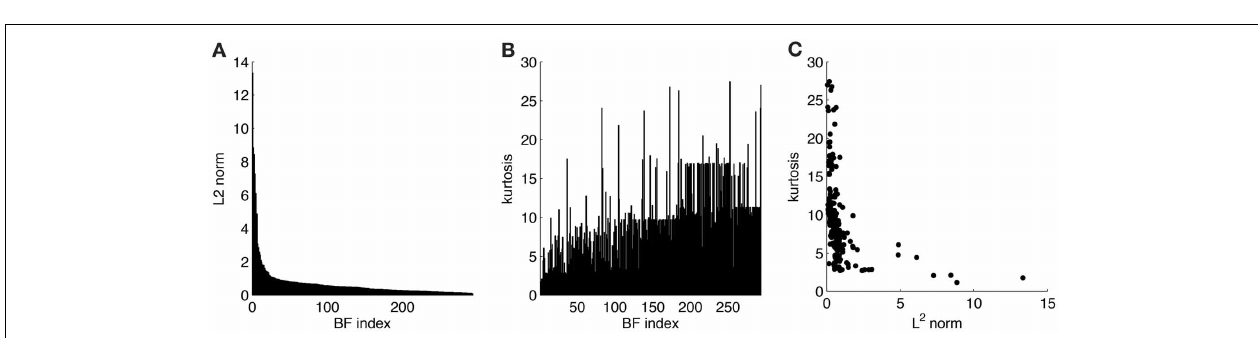
FIGURE 4 | Statistics for learned ICA basis functions. (A) Histogram of L 2 norms for every individual basis function after sorting. (B) Lifetime kurtosis of the source coefficients for each basis function (sorted as in A ). (C) Lifetime kurtosis vs. the L 2 norm.